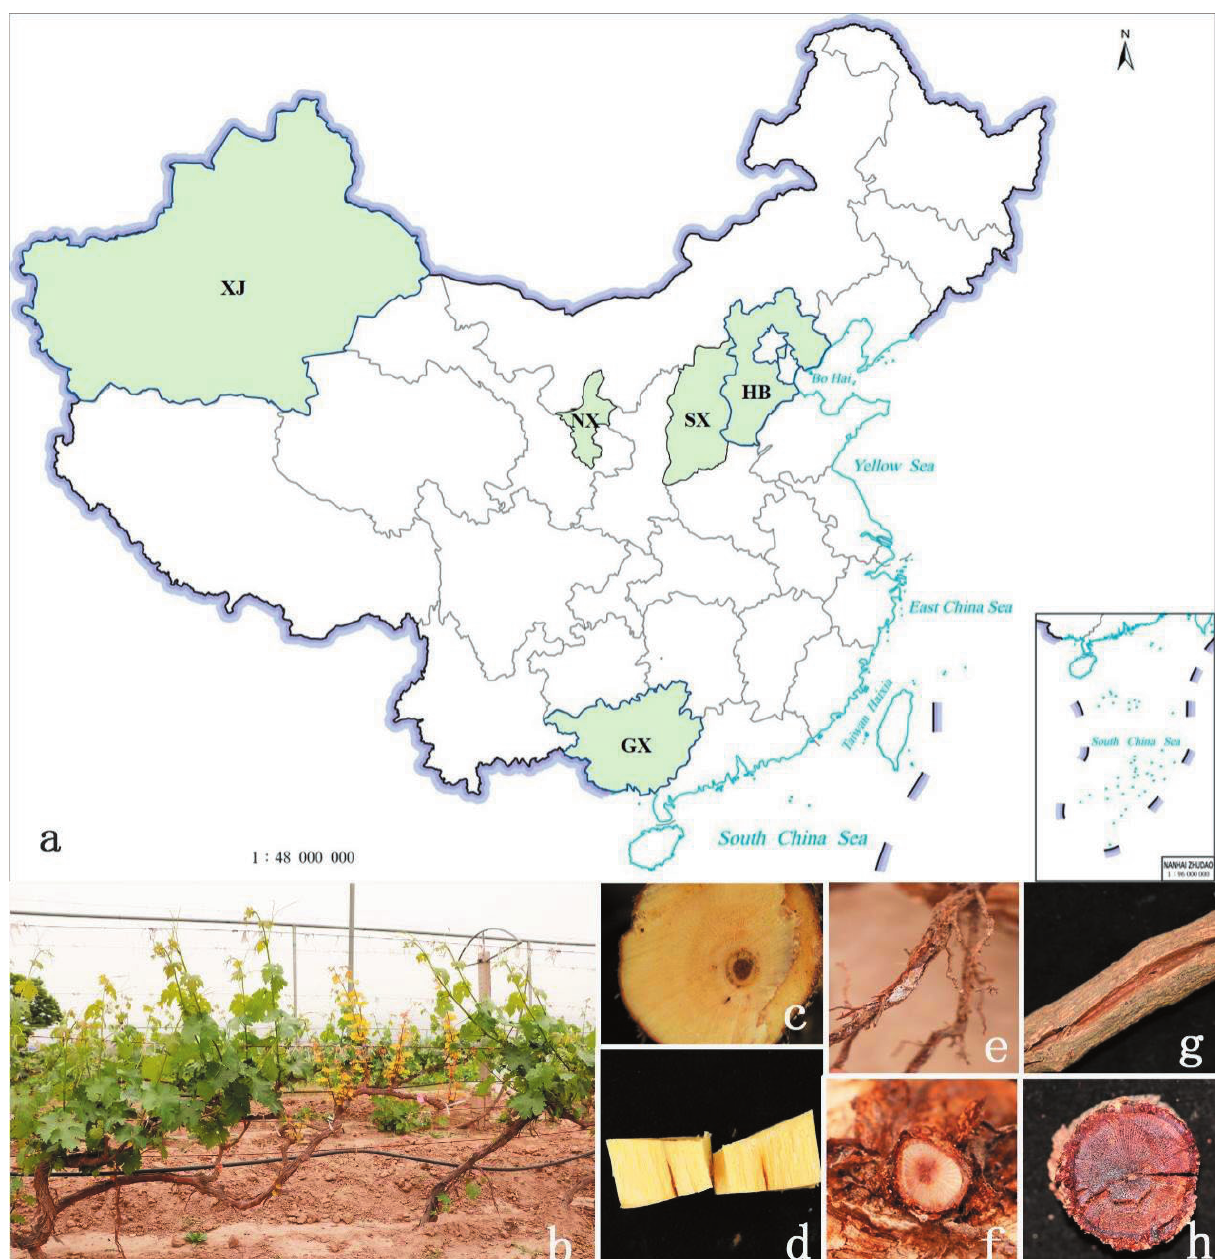
Figure 1. Sample collection sites and disease symptoms. Field surveys were carried out in five provinces of China. GX: Guangxi; HB: Hebei; NX: Ningxia;SX: Shanxi; XJ: Xinjiang ( a ). Diseased plant (Chardonnay, 5-year-old) showing shortened internodes of shoots ( b ).Necrotic grapevine roots and trunks ( c–h